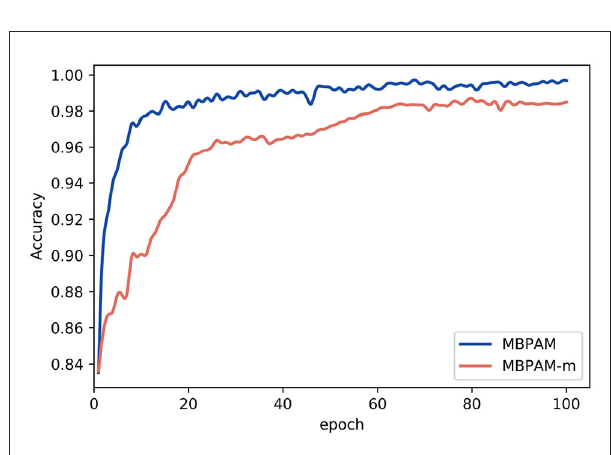
FIGURE7 The comparison of MBPAM model and MBPAM-m’s accuracy variation